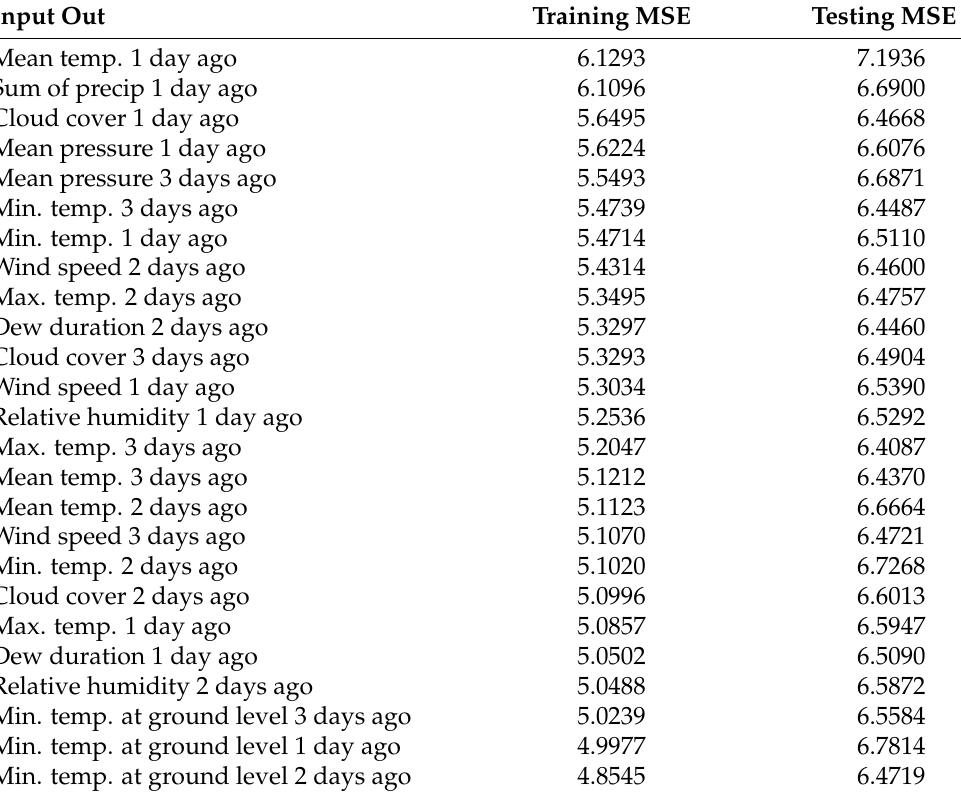
Table A2. The results of the sensitivity analysis for the prediction of the maximum daily temperature. Input